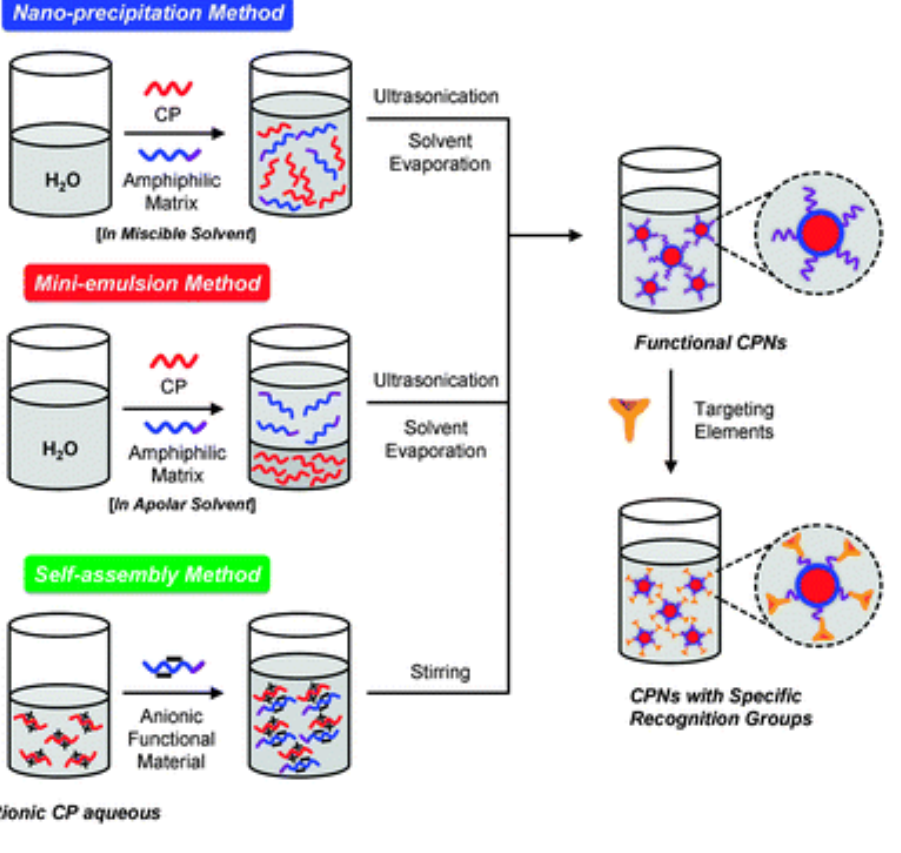
Fig. 1. Schematic representation of methods for preparing conjugated polymer